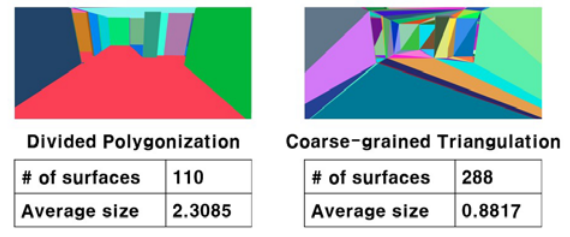
Figure 15. Two polygonization methods comparison